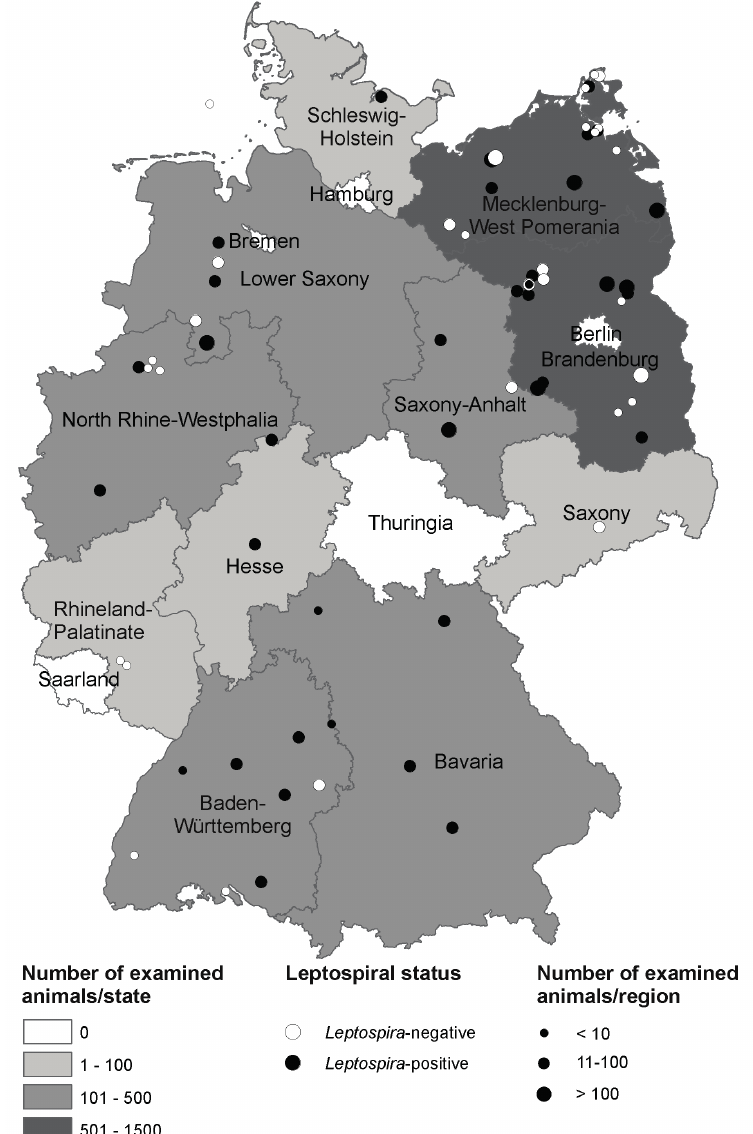
Figure 1. Number and leptospiral status of rodents and shrews trapped in the German federal states. The trapping site in the North Sea lies on the Island Helgoland. Several trapping regions defined by postal code include more than one trapping site. The map was created by ArcGIS 9.4 (ESRI, Redlands, CA,